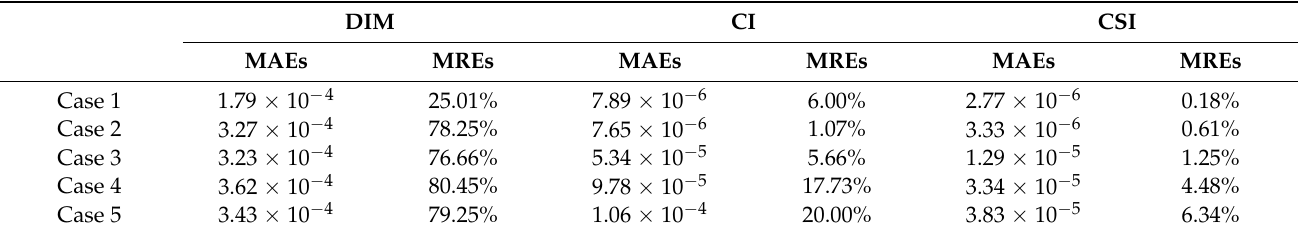
Table 4. The mean absolute error (MAE) and mean relative error (MRE) between the prescribed and inverted WSDCs with different schemes in different cases.